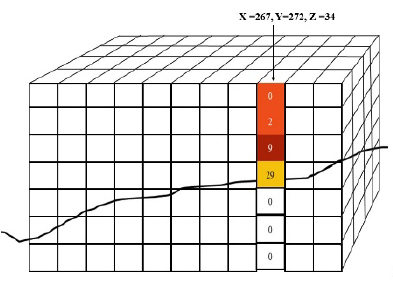
Figure 11: Representation of figure 10 at x= 267, y= 272 & z= 34 in a voxel space of 534 x 543 x 67 When analysing the voxel space column by column, i.e. one (x,y)-position at a time (Figure 10 and Figure 11), and identifying the terrain as the lowest non-zero voxel in a column,